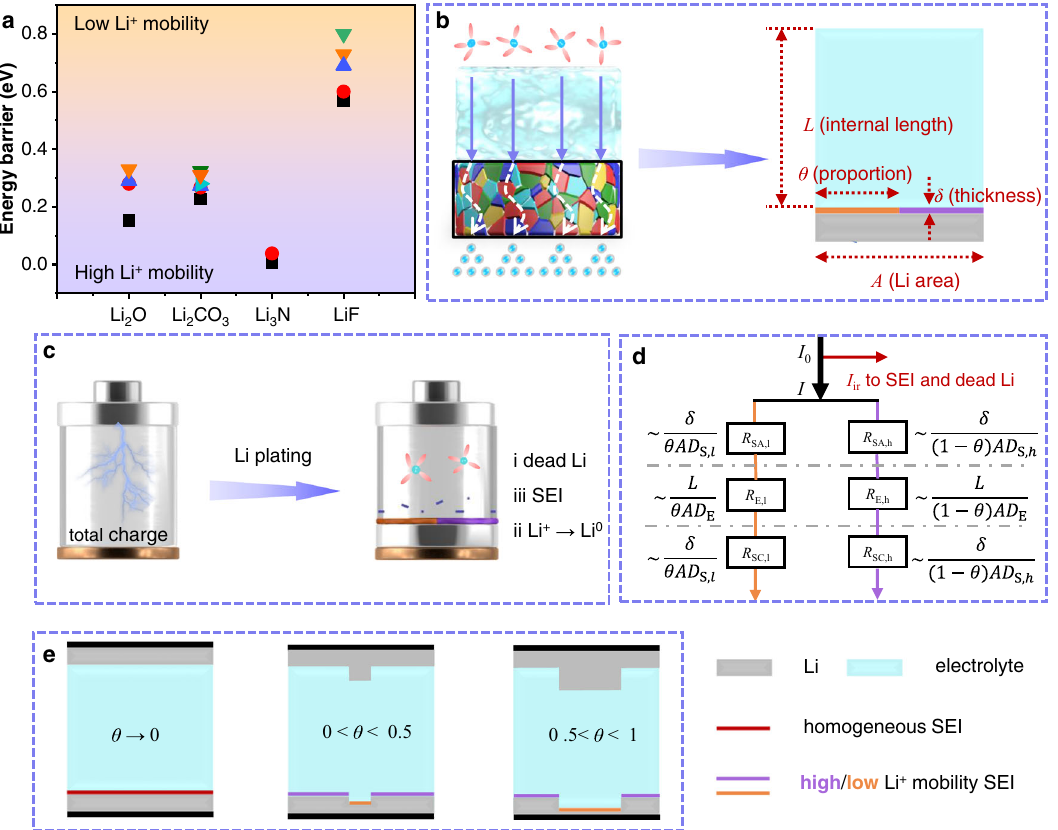
Fig. 1 | Model of Li deposition in LMBs. a Diffusion energy of Li + diffusion for various SEI components 34,66 – 69 . b Schematic illustration of Li deposition process and model parameters. c Capacity conservation during a complete Li deposition